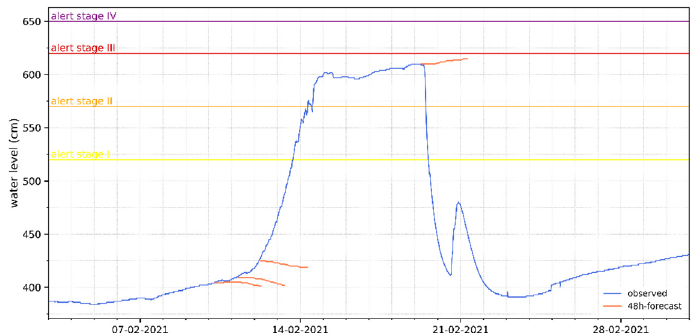
Figure 14. Measurement and forecast of water levels at the gauge at Hohensaaten-Finow, February 2021 (source: Landesamt für Umwelt Brandenburg).